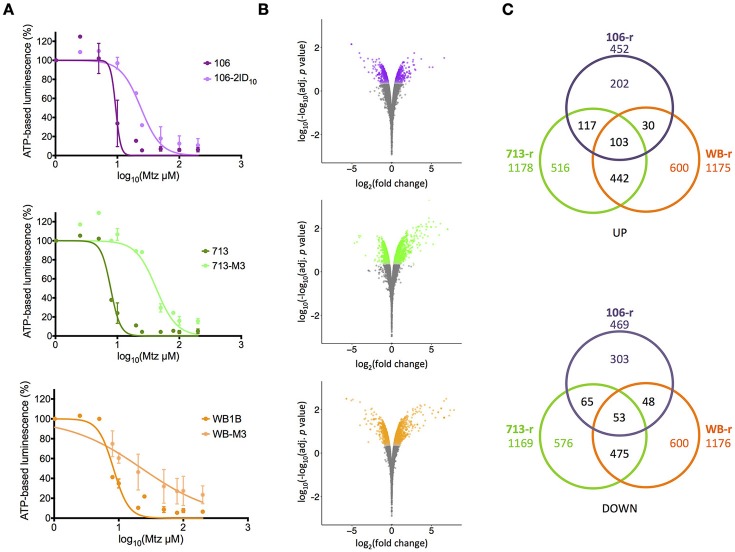
Metronidazole dose-response and differential transcription in resistant lines. (A) Dose-response curves for metronidazole-susceptible lines (dark colors) and resistant progeny (light colors). Experiments performed in biological duplicate. Error bars represent ± 1 standard deviation. (B) Fold-change in transcriptional abundance in resistant lines relative to susceptible parents. Significantly differentially transcribed genes (corrected p < 0.01) are displayed in color. Y-axes represent log-log-transformed corrected p values, where higher numbers indicate greater significance. (C) Numbers of significantly up-regulated (top panel) and down-regulated (bottom panel) genes shared between resistant lines. The total number of differentially transcribed genes is displayed beneath the line name.